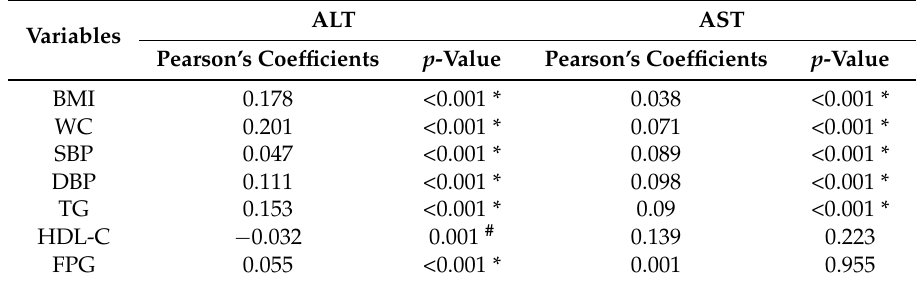
Figure 2. Adjusted odds ratios for having MetS in four age groups, for ( A ) ALT and ( B ) AST. Table 5 showed the Pearson’s correlation coefficients between the liver enzyme levels and other metabolic variables after adjusted for age and sex. The ALT level was positively correlated with the following factors: BMI, WC, SBP, DBP, TG, and FPG; negative correlation was observed for HDL-C. Similarly, the AST level was positively correlated with all the variables listed above, except for HDL-C and FPG. Table 5. Correlation between serum liver enzymes and investigated variables after adjustments for age and sex.